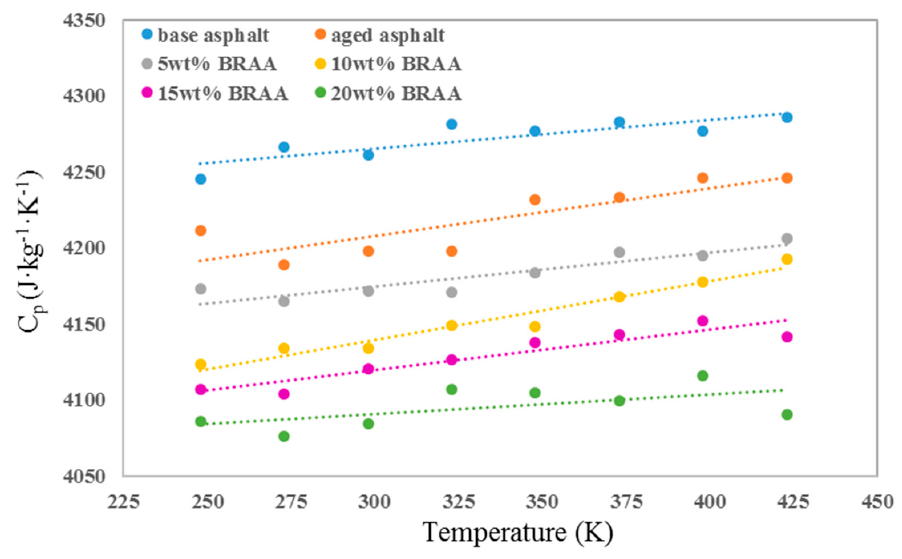
Figure 3. Specific heat capacities of asphalt systems.